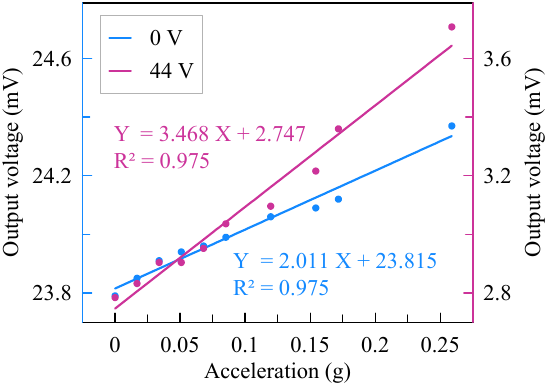
Figure 10. Frequency and stiffness variation.